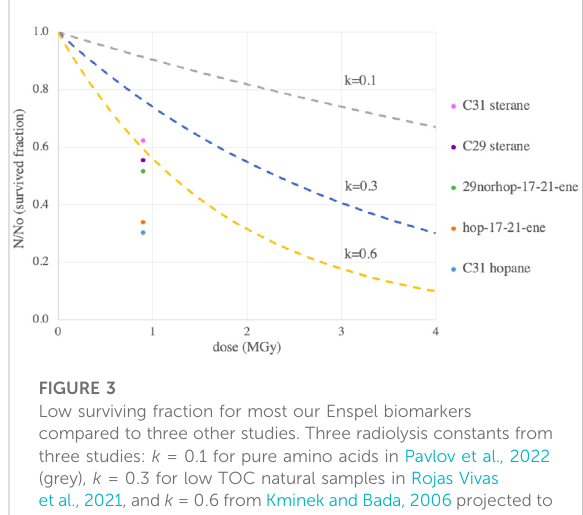
FIGURE 3 Low surviving fraction for most our Enspel biomarkers compared to three other studies. Three radiolysis constants from three studies: k = 0.1 for pure amino acids in Pavlov et al., 2022 (grey), k = 0.3 for low TOC natural samples in Rojas Vivas et al., 2021, and k = 0.6 from Kminek and Bada, 2006 projected to higher masses (428 Da). The signi fi cantly decreasing 3 hopanes and 2 steranes survived fractions are represented by dots at our dose of 0.9